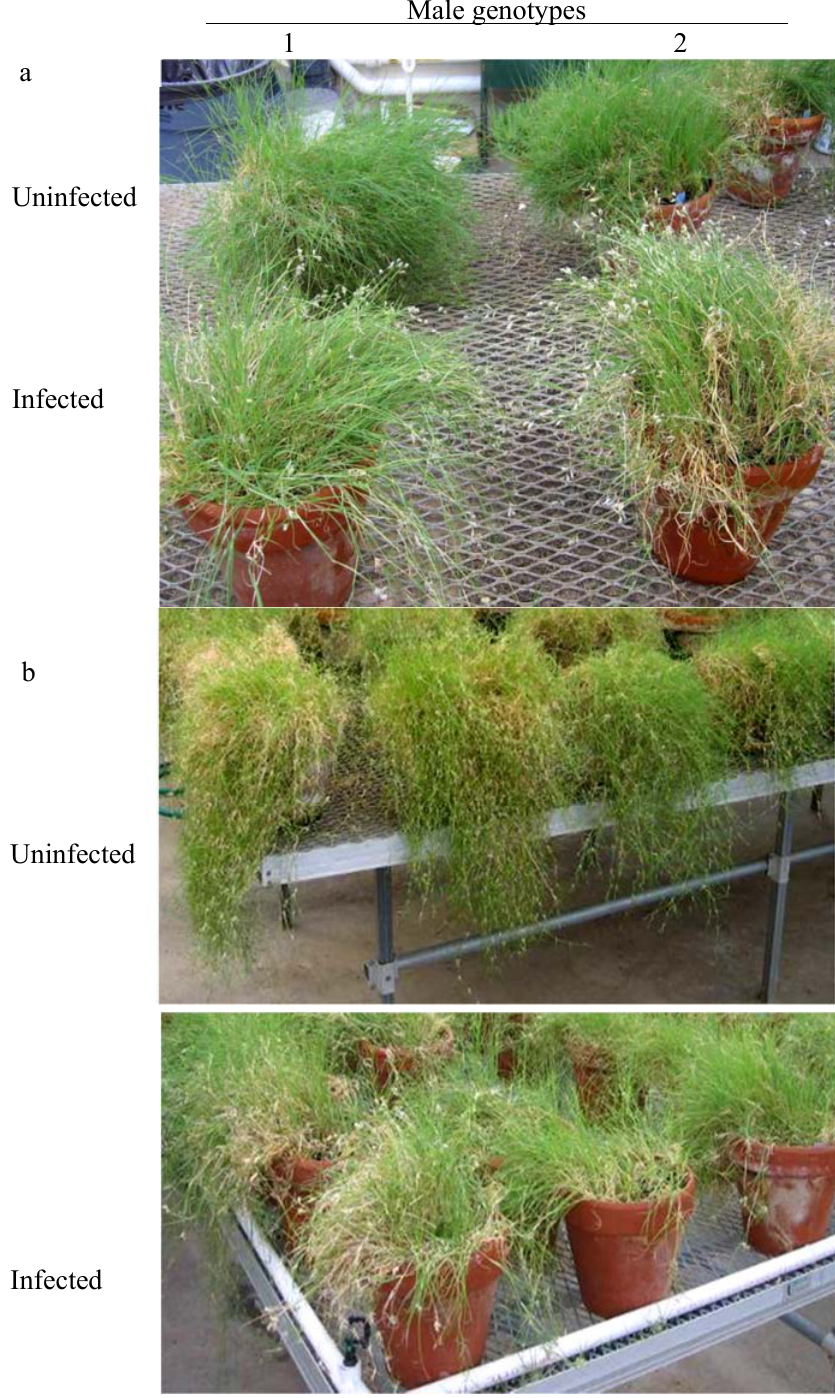
Figure 2. Effects of pistil smut infection on resource allocation in buffalograss. ( a ) infected male plants were observed to flower more profusely compared to uninfected clones of the same genotype. ( b ) uninfected male and female genotypes appeared to produce more vegetative stolons compared to infected